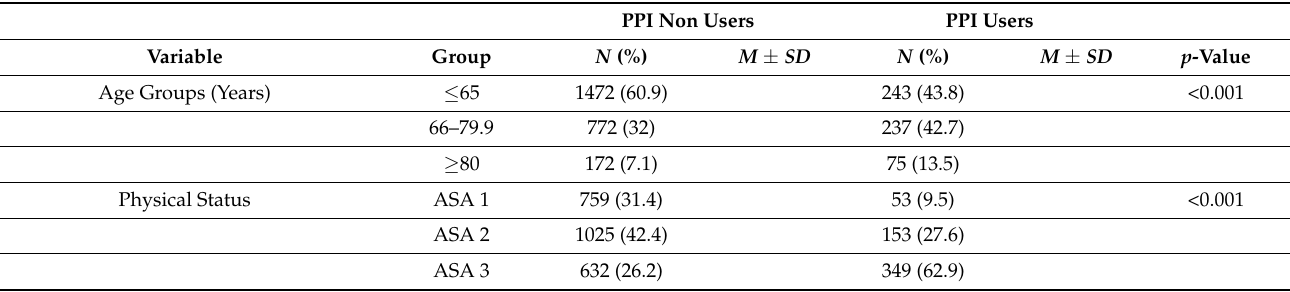
Table 1. Univariate tests at the implant